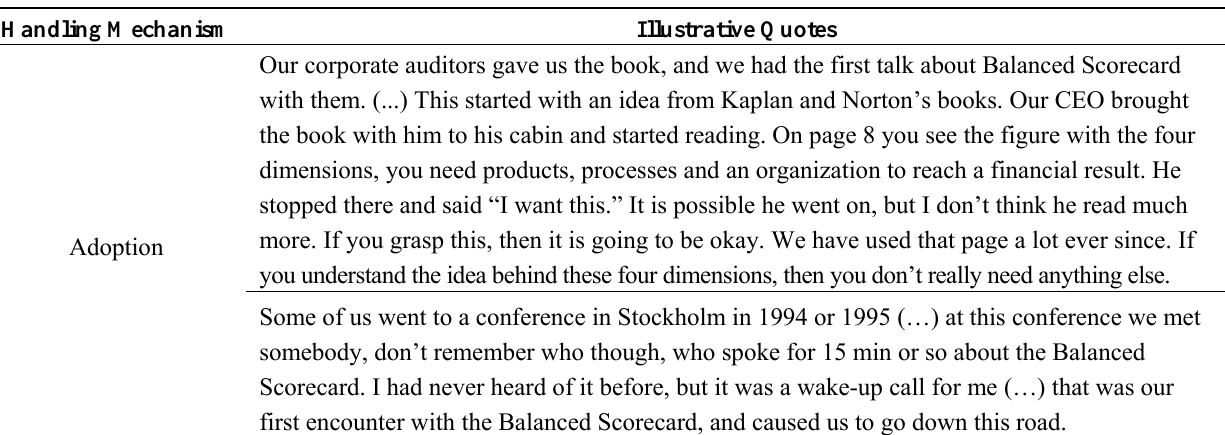
Table 7. Infectiousness of the